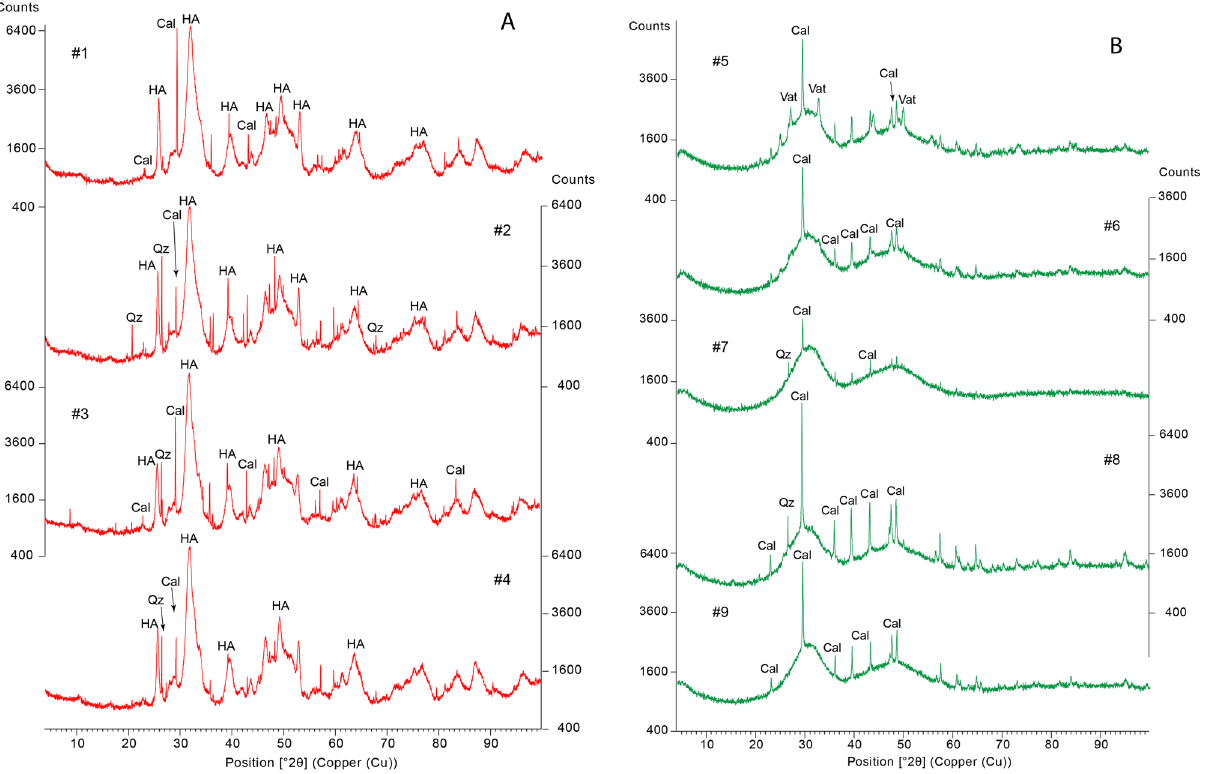
Figure 7. Mineralogy results using X-ray diffraction (XRD). ( A )—Coprolites recovered at ALV archaeological site. ( B )—Modern bearded vulture scats. HA—hydroxyapatite; Cal—calcite; Qz—quartz; Vat—vaterite.